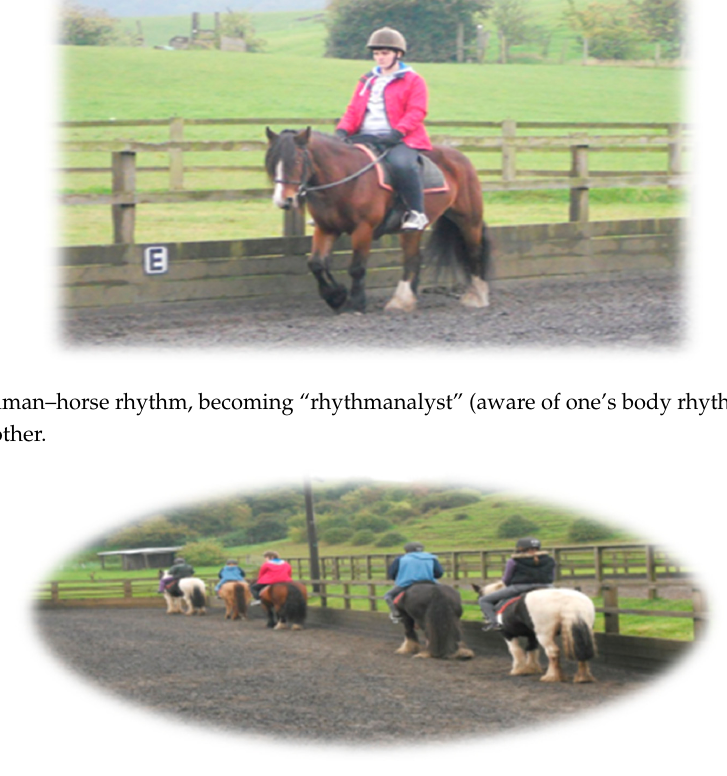
Figure 8. Shared and expanding spaces, creating “common worlds” and new “territory”.